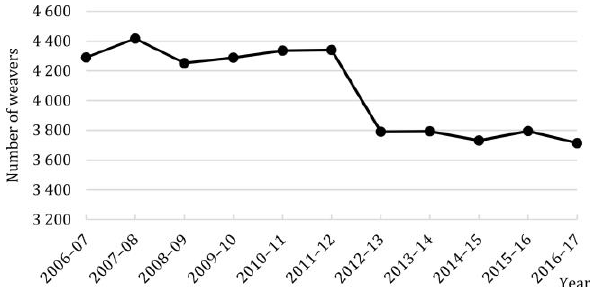
Fig. 1. Number of weavers (Chinsurah zone)